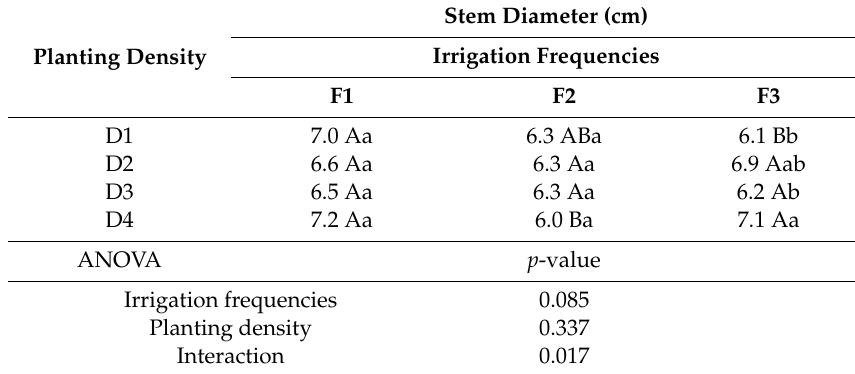
Table 3. Bean stem diameter as a function of di ff erent irrigation frequencies and plant densities.